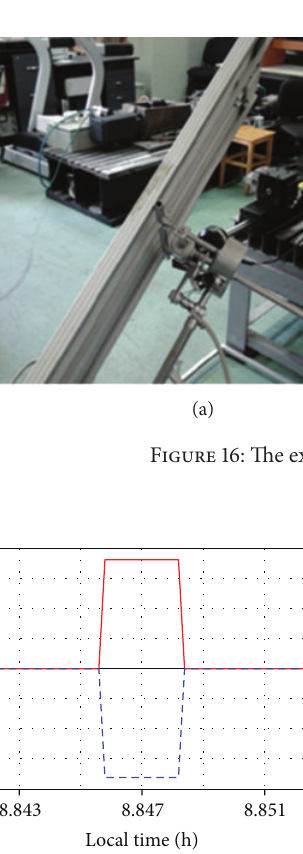
Figure 18: The tracking error for motor